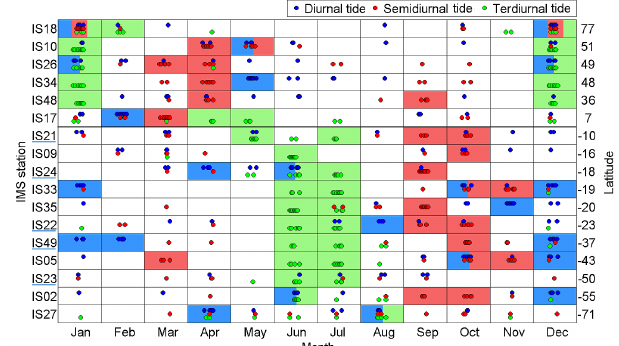
Figure 11. Detection times of the primary annual maxima of the tides’ variances between 2003 and 2015. The thicker black line depicts the transition from northern to southern latitudes. For the IMS infrasound station indicated on the left axis, each dot marks the month in which the absolute maximum of each year appeared between 2003 and 2015. The offsets between the dots serve for the purpose of distinguishability. By highlighting accumulations of annual maxima, seasonal patterns and its differences between the Northern Hemisphere and the Southern Hemisphere become appar-